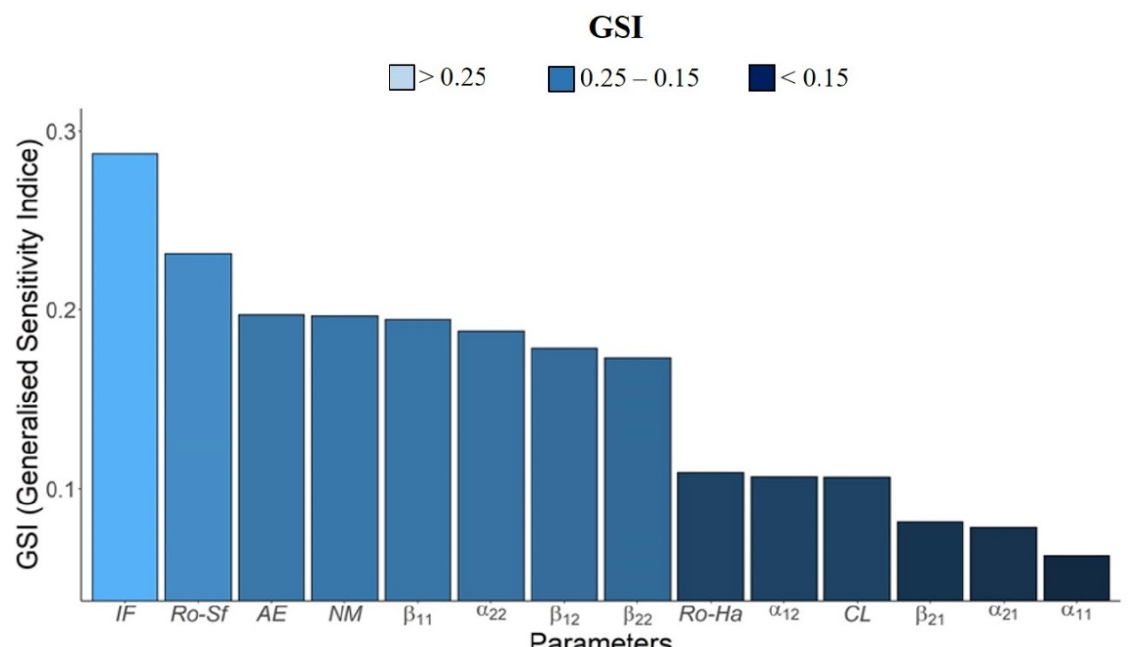
Figure 5. Generalized sensitivity index based on principal component analysis, for the following parameters: AE: Adult emergence. IF: Initial frequency. R0-Sf: Net reproduction rate of S. frugiperda . R0-Ha: Net reproductive rate of H. armigera . NM: Natural mortality. CL: Control level. α 11: Survival of S. frugiperda in intraspecific competition at low densities. α 12: Survival of S. frugiperda in intra- and interspecific competition at low densities. α 21: Survival of H. armigera in intra- and interspecific competition at low densities. α 22: Survival of H. armigera in intraspecific competition at low densities. β 11: Survival of S. frugiperda in intraspecific competition at high densities. β 12: Survival of S. frugiperda in intra- and interspecific competition at high densities. β 21: Survival of H. armigera in intra- and interspecific competition at high densities. β 22: Survival of H. armigera in intraspecific competition at high densities. (For a color version of this figure, the reader is referred to the web version of this article.).